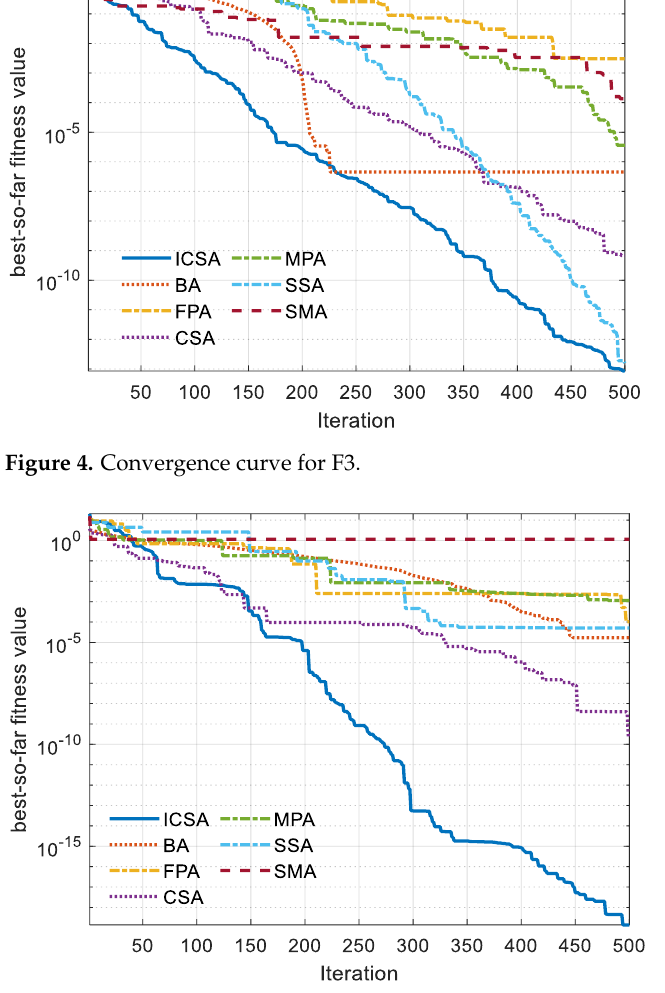
Figure 5. Convergence curve for F4.